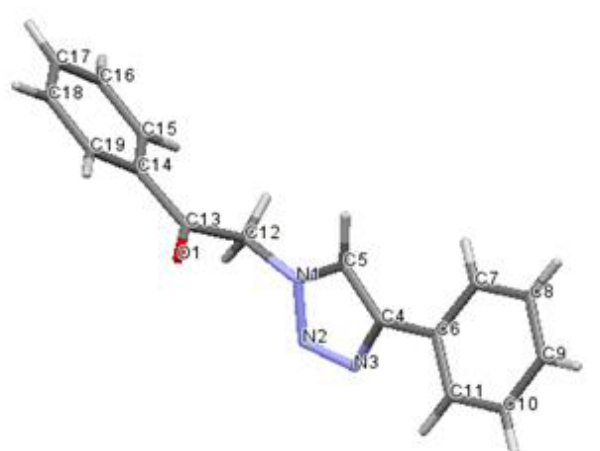
Figure 3. Scope of various alkynes in CuAAC with tosyl azides under mechanochemical conditions. Reaction conditions: Ar/HetAr alkynes 1b – f (1 equiv.), tosyl azide 4a (1.2 equiv.), 5-Cu beads, 500 rpm.